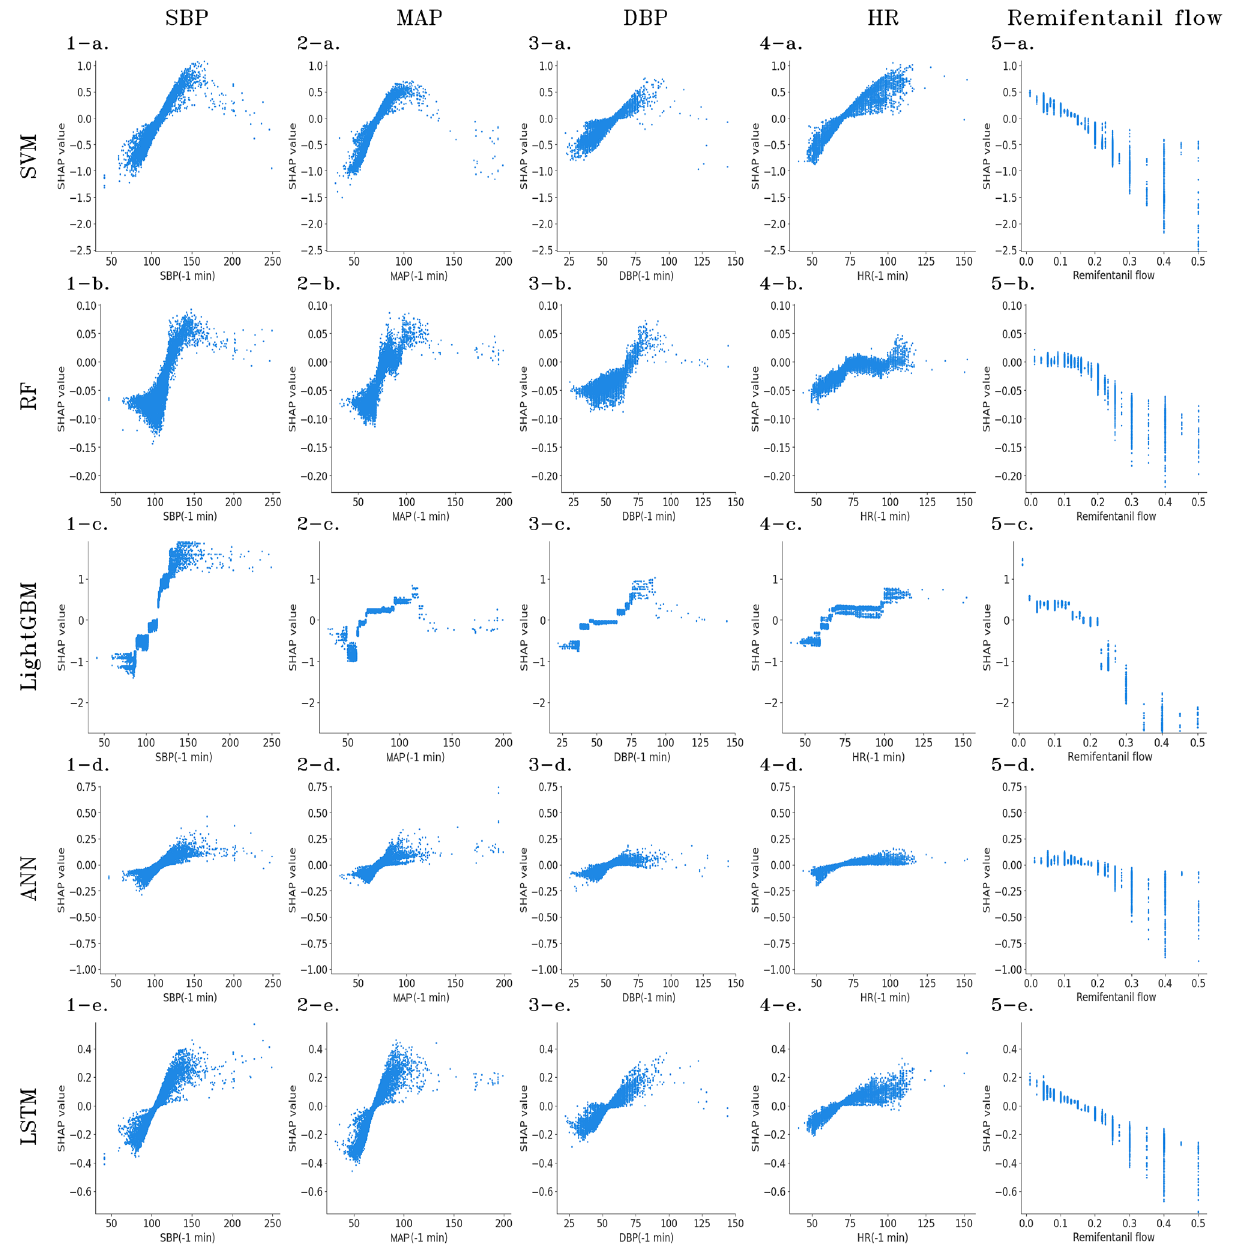
Figure 3. Contribution of each feature to individual predictions. The x-axis represents the value of the feature, and the y-axis represents the SHAP value. Positive SHAP values indicate the model tends to predict that the flow will increase, whereas negative values indicate that the flow will not increase. BP and HR show correlations with SHAP values, whereas remifentanil flow shows negative For each of the features of particular importance in the aforementioned analysis, which namely, SBP, MAP, DBP, HR, and remifentanil flows immediately before the prediction, we analyzed the contribution of each to the prediction results. In the scatter plots in Fig. 3, the x-axis represents the value of the feature and the y-axis represents the SHAP value. If the SHAP value was positive, the model tended to predict that the flow would increase; conversely, if the value was negative, the model tended to predict that the flow would not increase. Note that, because logistic regression is a linear model, the points are plotted on a straight line, and therefore, the results are omitted. For SBP, there was a positive correlation between the vital and SHAP values. Furthermore, considering the value at which the positive and negative SHAP values switch, the threshold value for all models was approximately 100–125 mmHg. A scatter plot with a similar shape is drawn for MAP, and the boundary between the positive and negative SHAP values was approximately 70–90 mmHg. A similarly shaped scatter plot is drawn for DBP; however, the variance of SHAP values was smaller than that of SBP and MAP, indicating that the influence of